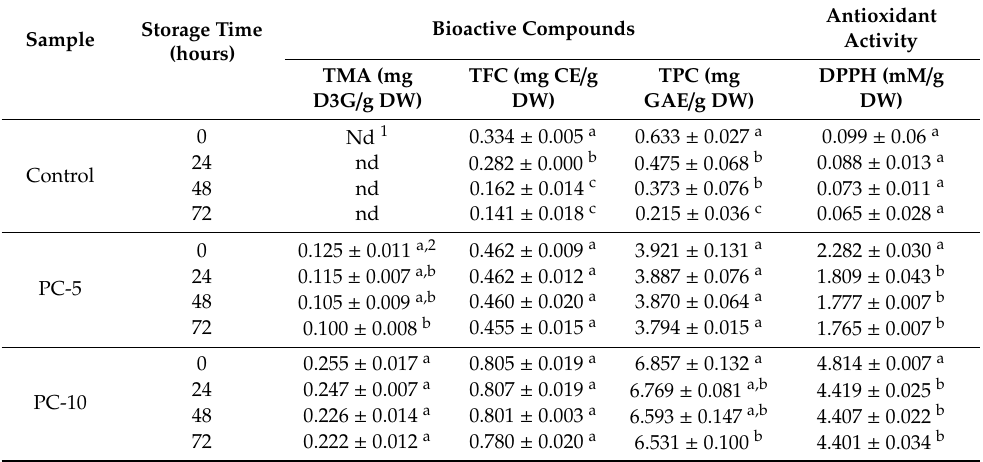
Table 1. Phytochemical characterization and antioxidant activity of pastry cream enriched with